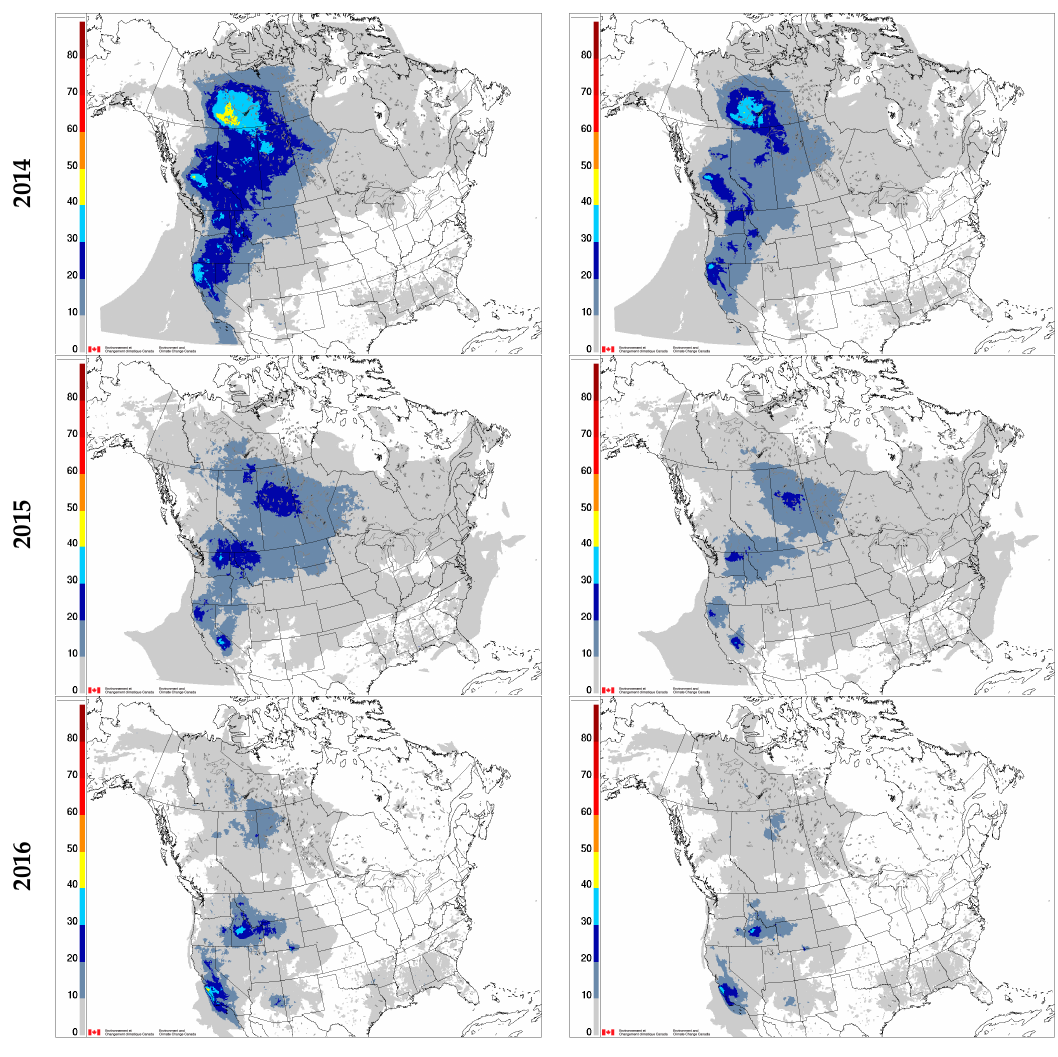
Figure 10. Same as Figure 9 but for 5 µg/m 3 .